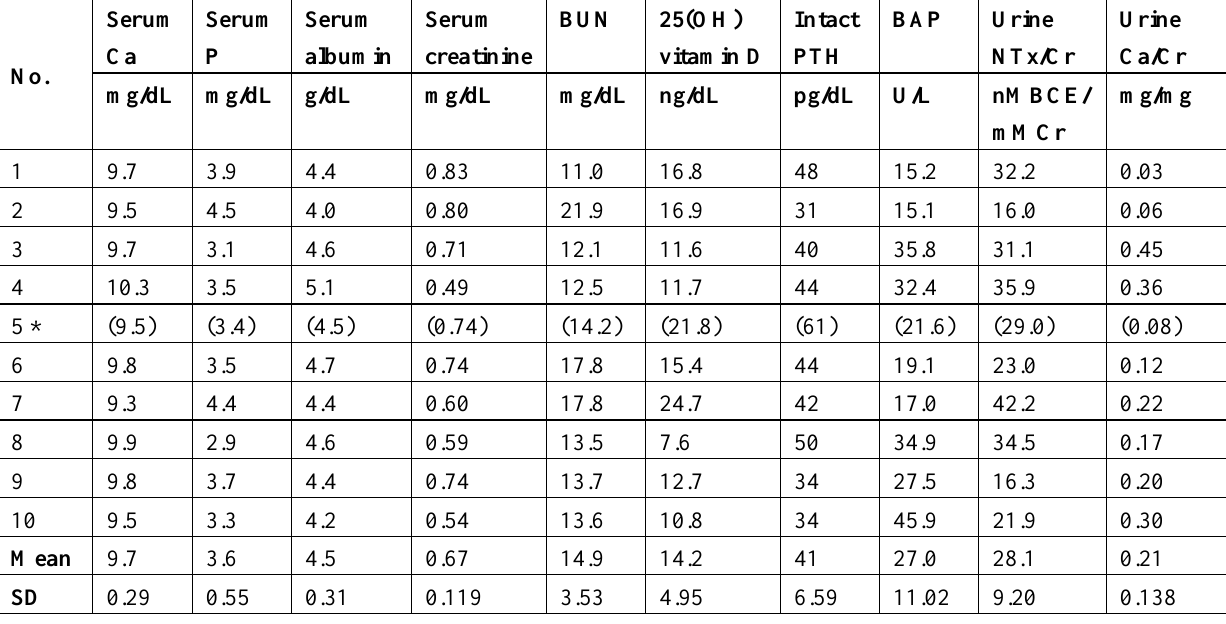
Table 2. Parameters of mineral and bone metabolism of the test